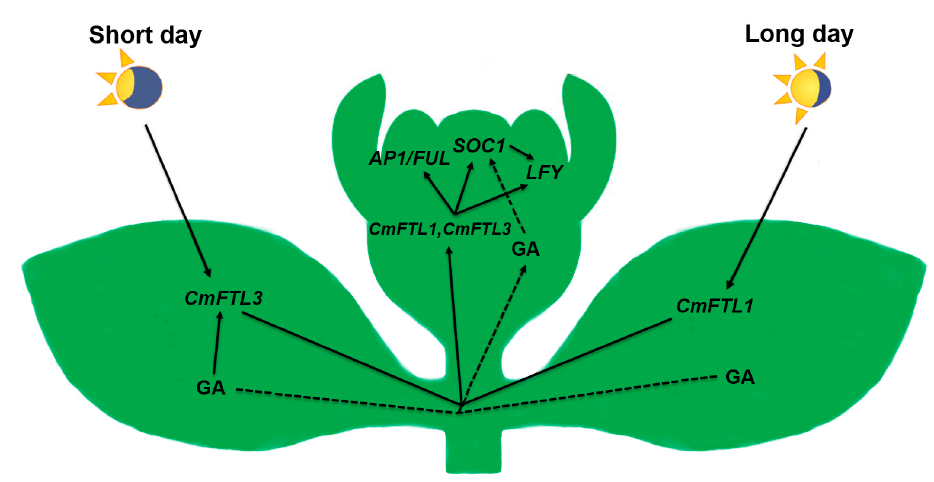
Figure 5. A model of the floral induction regulatory networks operating in chrysanthemum ‘Jinba’ plants grown under LD or SD.